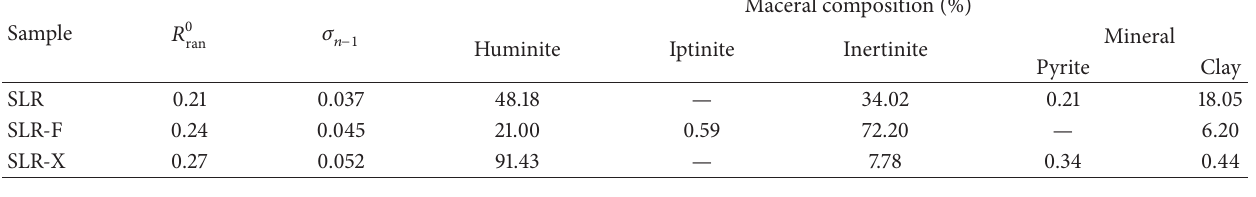
Table 2: Lithofacies analysis of SLR, SLR-X, and SLR-F.